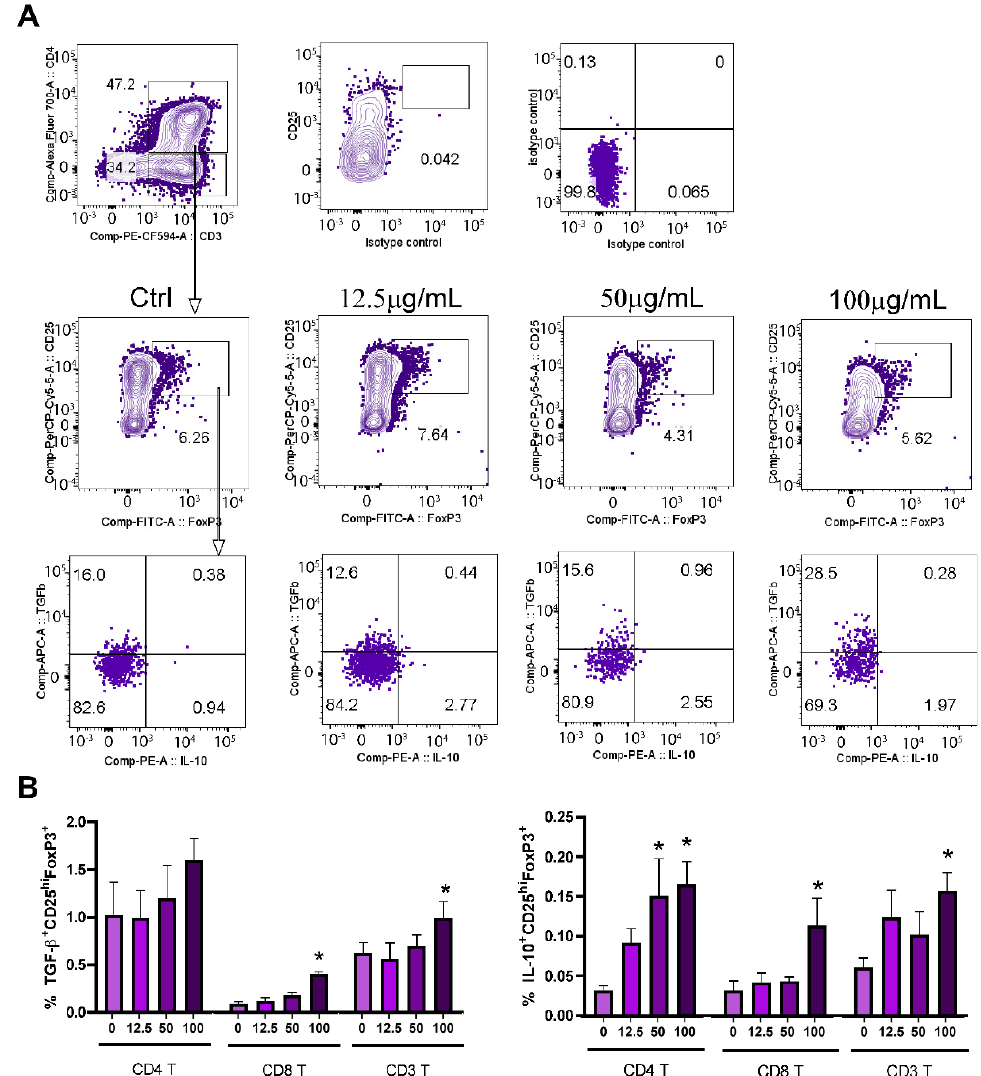
Figure 10. The effects of PoPEx on CD4 + and CD8 + Tregs within PHA-stimulated PBMC. PBMC (3 × 10 5 /well) were cultured with PoPEx (12.5 µg/mL, 50 µg/mL or 100 µg/mL) or without PoPEx (ctrl), in the presence of PHA (10 µg/mL) for 3 days. ( A ) A representative analysis of IL-10 and TGF- β expression within CD25 hi FoxP3 + CD3 + CD4 + (CD4 T) is shown, along with isotype and CD25/isotype (FMO) control. Similar analysis was performed within CD25 hi FoxP3 + CD3 + CD4 − (CD8 T) and for total CD25 hi FoxP3 + CD3 + (CD3 T) cells (not shown). ( B ) The summarized data on % of TGF- β + CD25 hi FoxP3 + and IL-10 + CD25 hi FoxP3 + within CD3 T, CD4 T and CD8 T are shown as mean ± SD (n = 3). * p < 0.05, compared to control non-treated PHA-PBMC (One-way ANOVA; Dunn’s multiple comparison